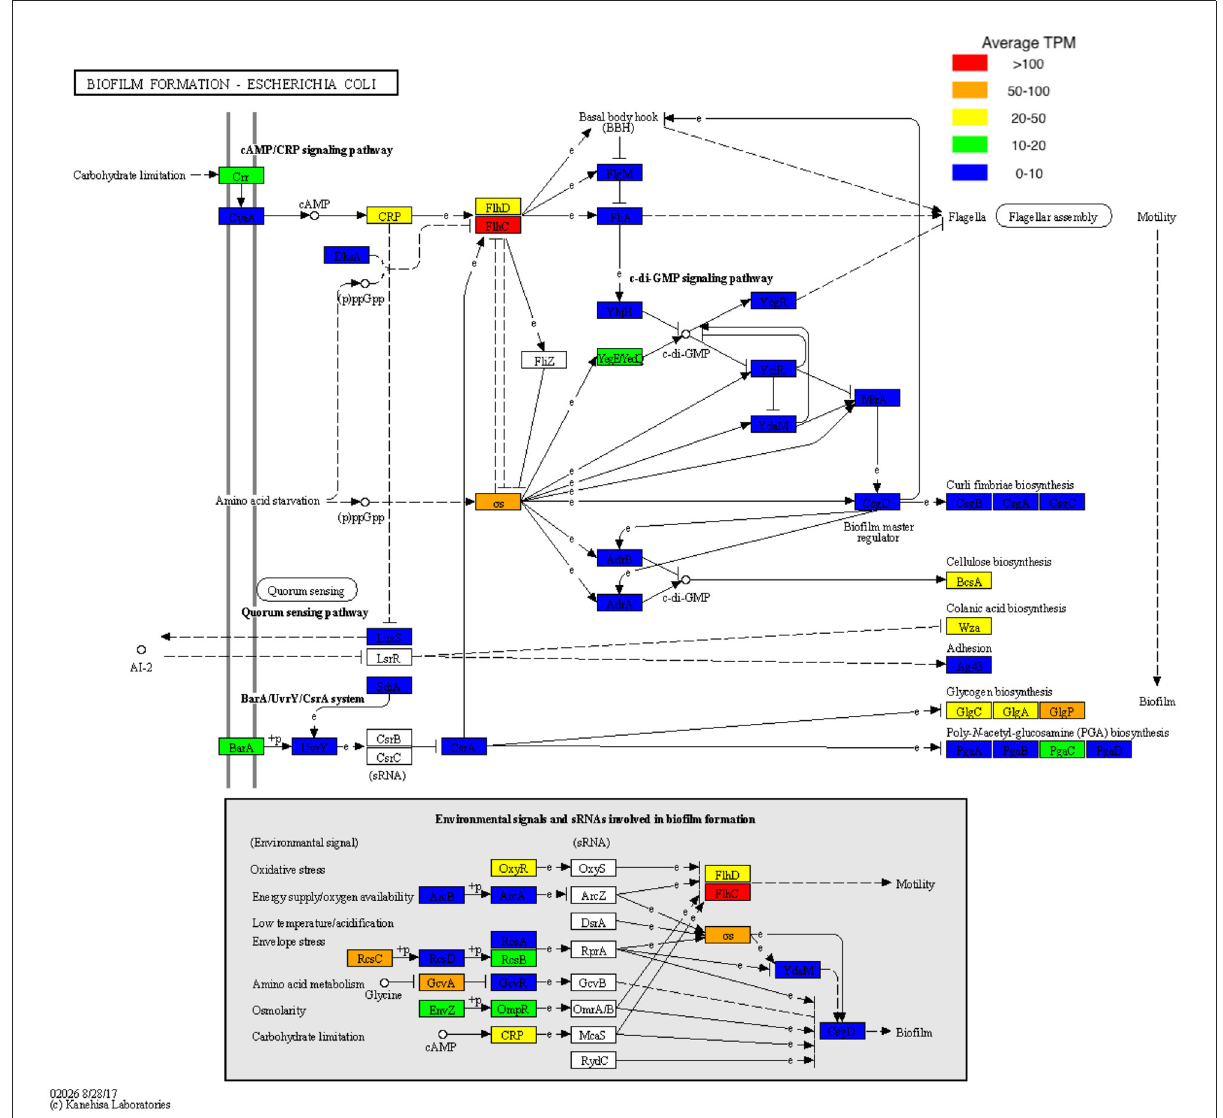
FIGURE4 KEGG pathway map of pathway eco02026 with biofilm TPM data superimposed. TPM values were averaged across all samples and stratified based on TPM count prior to being visualized onto pathway